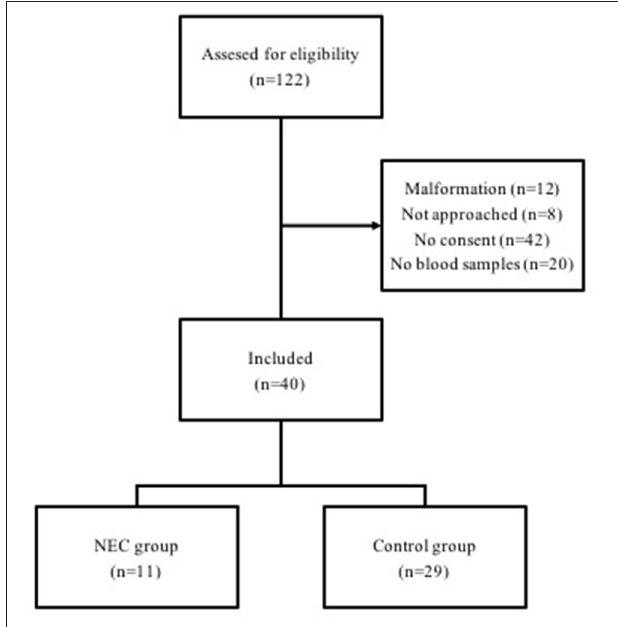
FIGURE 1 | Flowchart of included infants ( n = 40) born between 22 and 27 weeks of gestational age, and reasons for exclusion.